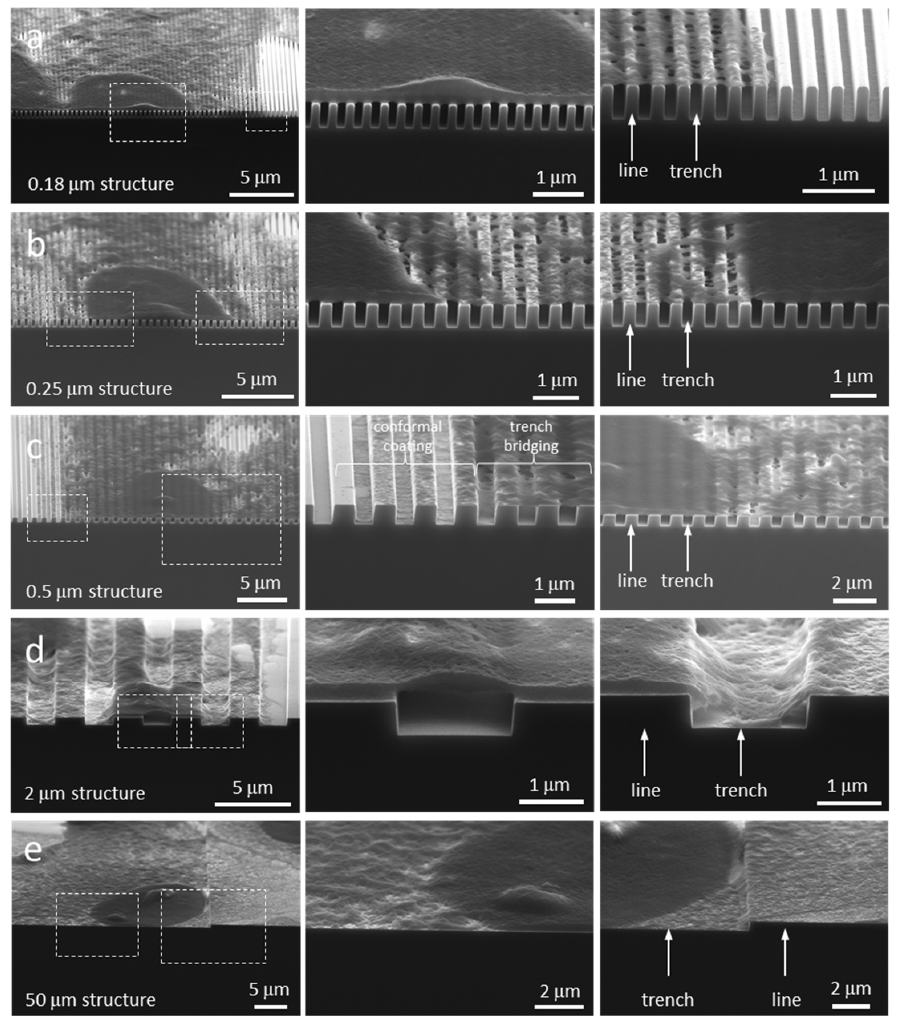
Figure 6. Typical SEM micrographs of cross-sectioned cells on the comb structures with trench widths of ( a ) 0.18, ( b ) 0.25, ( c ) 0.5, ( d ) 2, and ( e ) 50 µ m. Table 1. Number of cells inspected in each comb structure and the corresponding type of morphology.